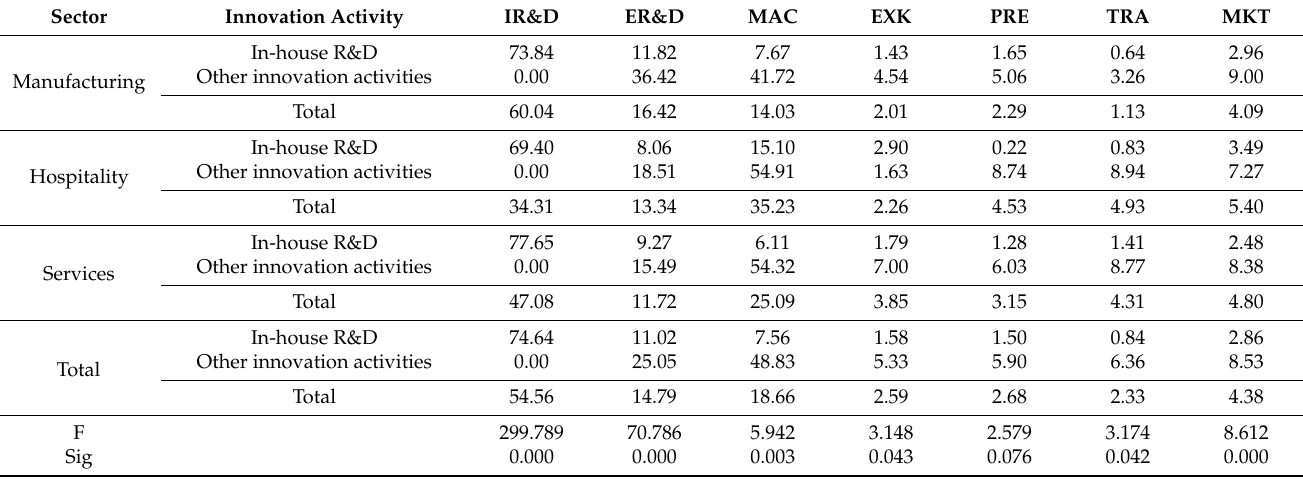
Table 8. Expense in innovation activities by industry (%) and ANOVA.